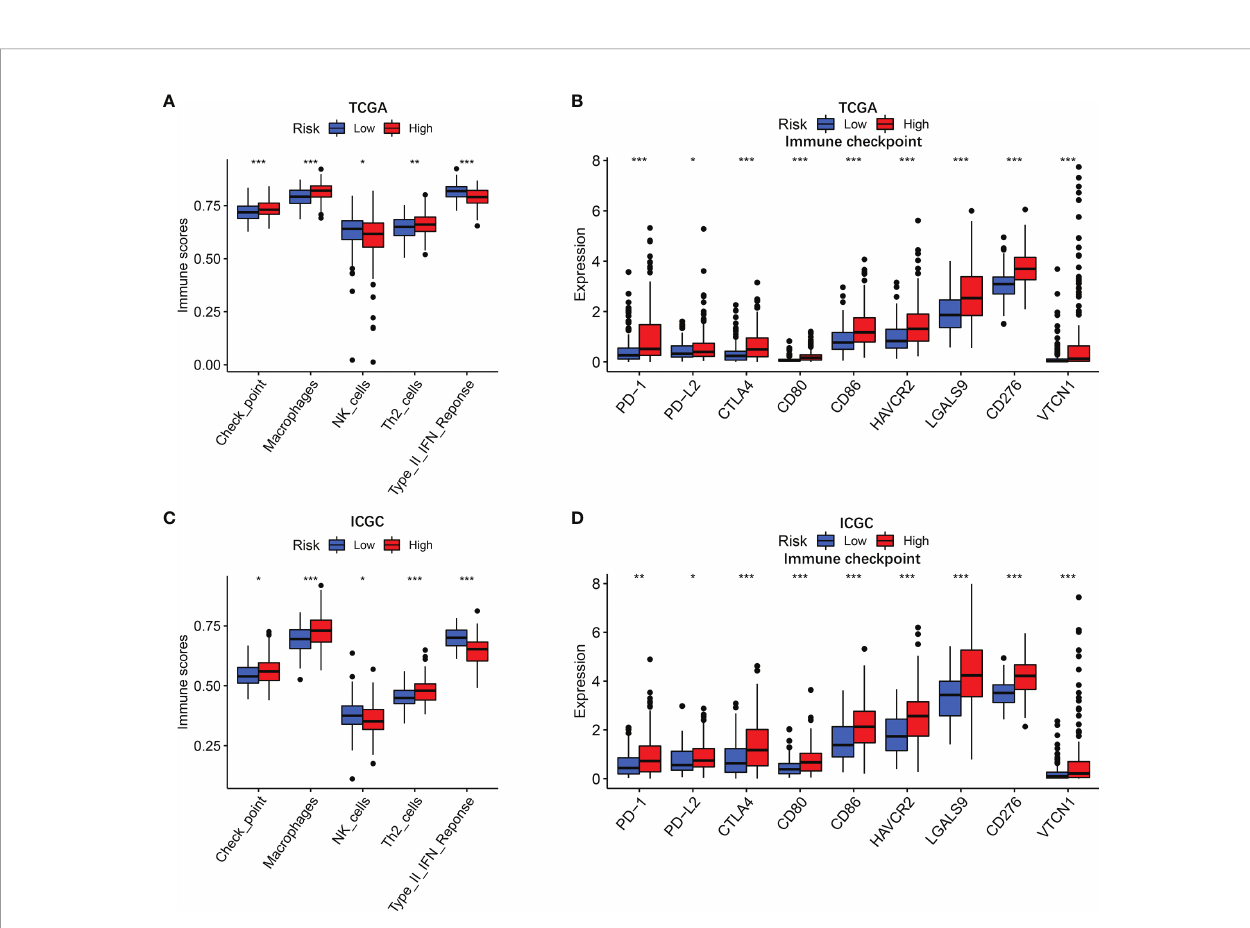
FIGURE 5 | Immune status in different risk groups. TCGA cohort (A, B) , ICGC cohort (C, D) . (A, C) The relative enrichment of 5 immune-related risk terms in different risk groups. (B, E) The associations of risk score with PD-L2 expression and galectin-9 expression. (B, D) Expression levels of immune checkpoints in different risk groups. P values were showed as: ns, not signi fi cant; *P < 0.05; **P < 0.01; ***P < 0.001.